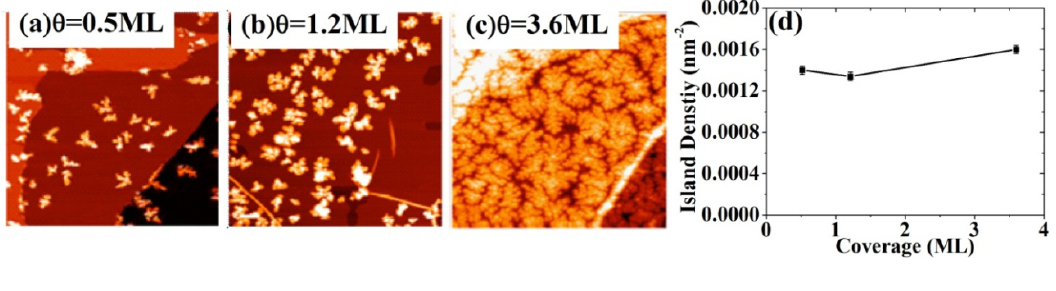
Figure 2. STM image of Gd on graphene ( a ) 210 × 210 nm 2 , θ = 0.5 ML; ( b ) 250 × 250 nm 2 , θ = 1.2 ML; ( c ) 250 × 250 nm 2 , θ = 3.6 ML; ( d ) Constant island density vs. coverage at room temperature (RT) for Gd on graphene with F = 0.12 ML/min.